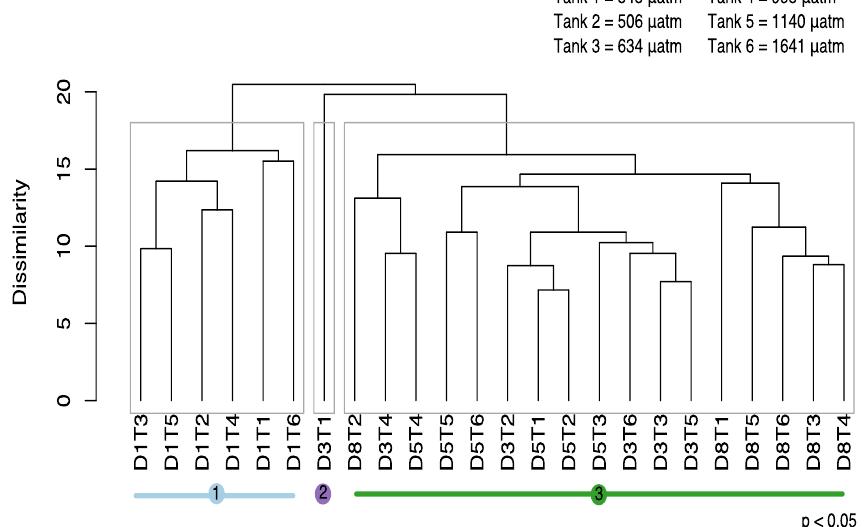
Figure 9. Cluster analysis based on similarity in protistan community structure among f CO 2 treatments and times during the acclimation period (days 1 to 8). In this analysis there are three significantly different groups identified by SIMPROF (denoted by grey boxes around clusters and coloured lines beneath sample labels). Samples are abbreviated according to days of incubation (D1–8) and f CO 2 treatment (T1–6 representing 343, 506, 634, 953, 1140, 1641µatm, respectively).